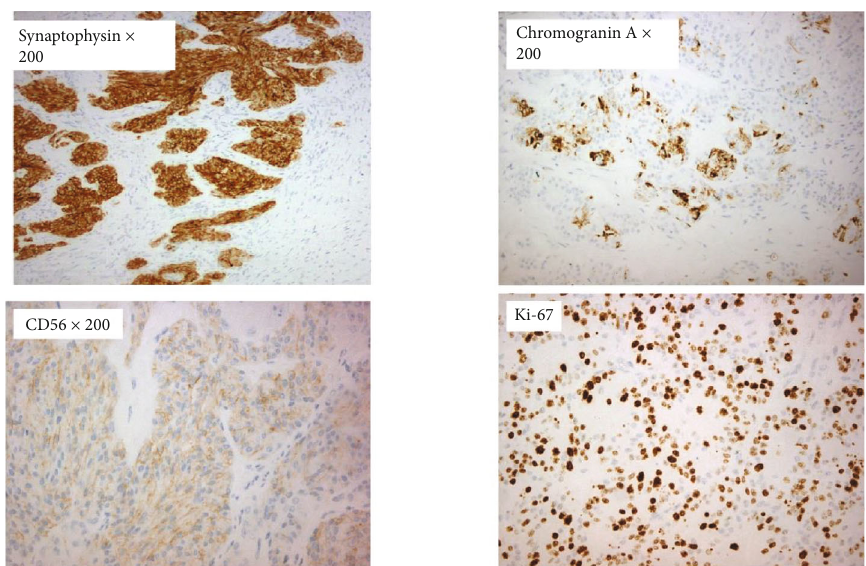
Figure 3: Positive neuroendocrine markers (chromogranin, synaptophysin, and CD56). High Ki-67 proliferation